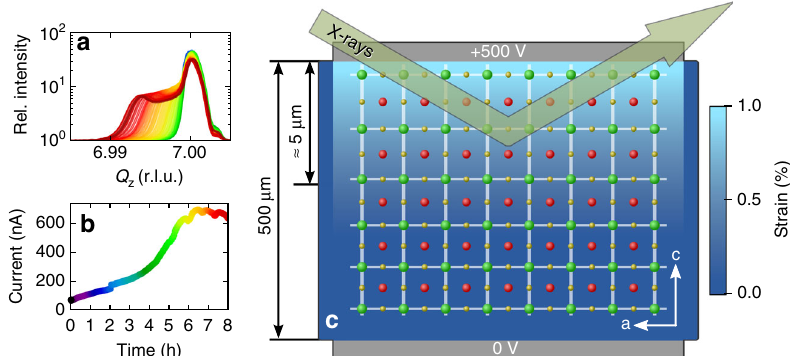
Resultsof fi ttingthetemperaturedependentexperimentalRXDspectratotheDebyemodel.The given errors correspond to 1 σ uncertainties